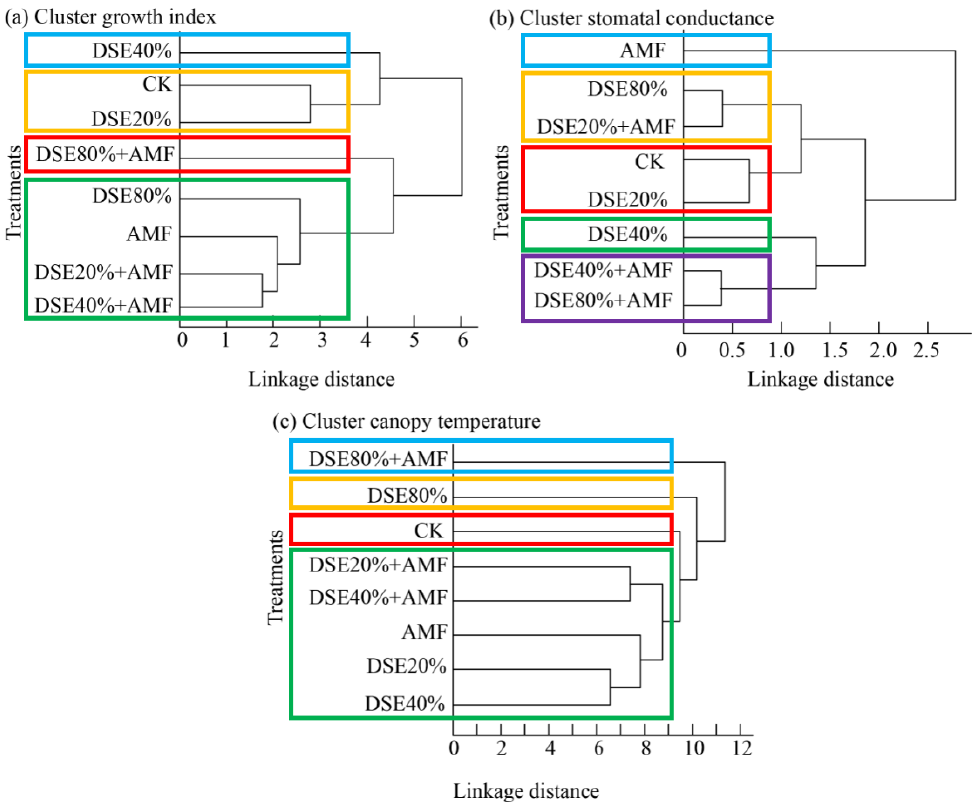
Figure 7. Cluster analysis: ( a ) growth index cluster analysis; ( b ) stomatal conductance cluster analysis; and ( c ) canopy temperature cluster analysis. Control (CK), treatments with sterilized DSE and AMF; DSE20%, 2 × 10 5 CFU mL − 1 of DSE with sterilized AMF; DSE40%, 4 × 10 5 CFU mL − 1 of DSE with sterilized AMF; DSE80%, 8 × 10 5 CFU mL − 1 of DSE with sterilized AMF; AMF, sterilized DSE with AMF; DSE20% + AMF → DSE80% + AMF, different concentration of DSE and